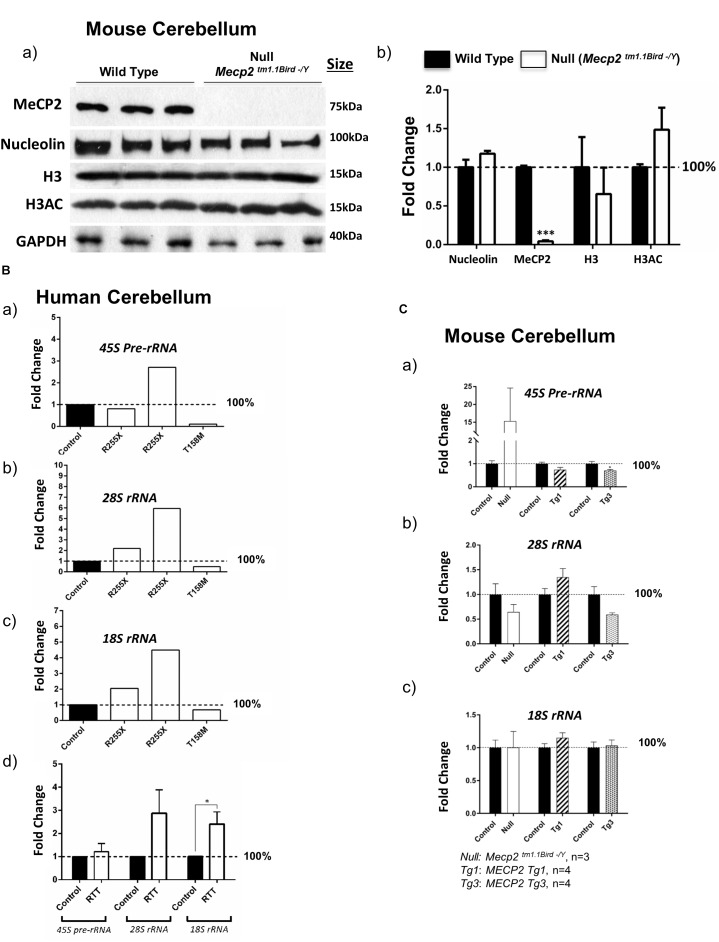
Nucleolin, MeCP2, histone H3, and histone H3 di-acetylation at K9-K14 (H3AC) in the murine cerebellum along with ribosomal RNA transcripts in the human and murine cerebellum. (A) Western blot (WB) analysis of the total cell extracts of wild type (WT) and Mecp2tm1.1BirdY/− (null, N = 3). As expected, no MeCP2 is detected in the Mecp2tm1.1BirdY/− cerebellum, and nucleolin levels are not changed. No obvious difference in nucleolin, H3, or H3AC is visible between the WT and Mecp2tm1.1BirdY/− null mice (a). Quantification of WB signals is provided in (b) confirming no change in the nucleolin, H3, and H3AC levels between the wild-type and null mice. N = 3 ± SEM for the WB for WT and null mice. Statistical significance was determined by paired t-test, with ∗∗∗p < 0.001. (B) Transcript levels of 45S precursor ribosomal RNA (rRNA) (a), mature 28SrRNA
(b), and 18SrRNA
(c) are shown for the human cerebellum. Human controls are NIH Neurobiobank #5646 and #5446, and RTT patients are in the order of NIH Neurobiobank #4516 and #4882, followed by T158M patient. Means of technical replicates are presented for individual patients. Combined patient data is shown in (d) for each rRNA transcript, with N = 2 for controls and N = 3 ± SEM for patients. (C) Transcript levels of 45S precursor ribosomal RNA (rRNA) (a), mature 28SrRNA
(b), and 18SrRNA
(c) are shown for the cerebellum of Mecp2tm1.1BirdY/− (null, N = 3), Tg1 (MECP2-Tg1, N = 4), and Tg3 (MECP2-Tg3, N = 4) mice compared to control cerebellum from WT controls. N = 3–4 ± SEM. Statistical significance for Bd and C was determined by Welch’s t-test, with ∗p < 0.05.